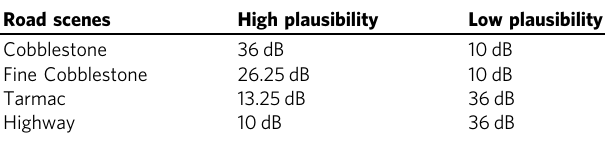
Table 2 Vibration levels of the vehicle seat in high plausibility and low plausibility scenarios in the main experimental task for each of the four